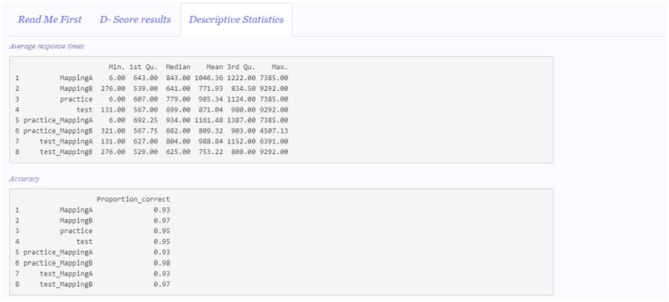
Descriptive statistics panel.